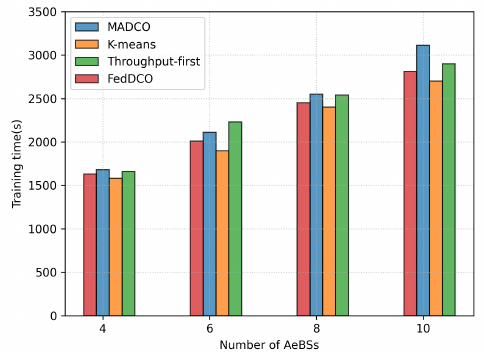
Figure 7. Training time of different